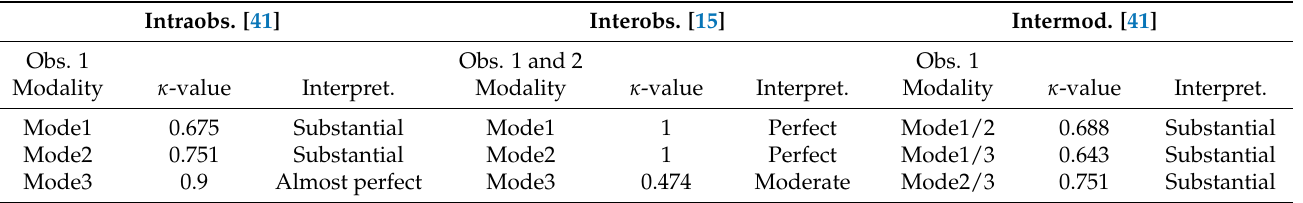
Table 3. κ -values for the intraobserver (intraobs.), interobserver (interobs.) and the intermodality